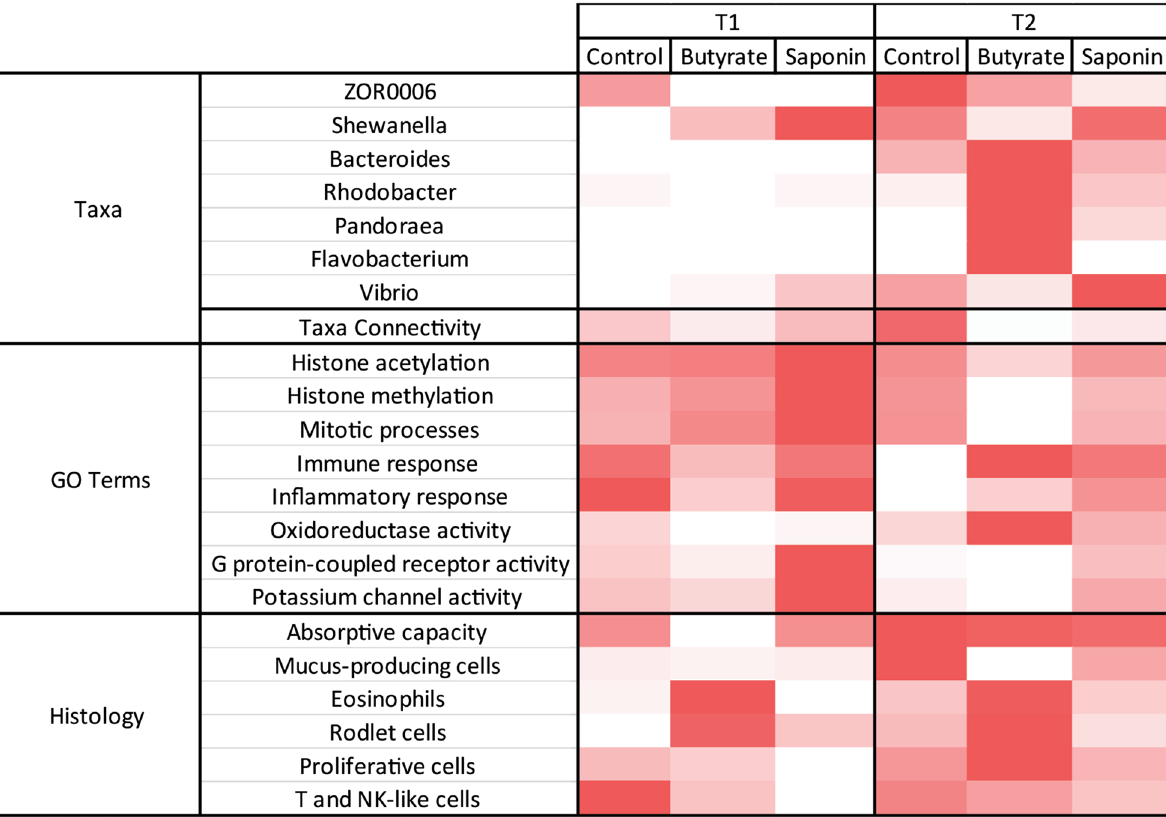
Fig. 8 The heatmap brings together the main observations of each analysis and compare them per diet and timepoint. The more representative genera are illustrated with the average relative abundance per timepoint and diet. The taxa connectivity contained the amount of pairs of taxa that correlate to each other in a significant fashion ( p 0.05). The GO terms contain the transcripts per million (tpm) of all genes expressed in the ≤ dataset that collapsed under that GO term. All histological parameters are normalized and scaled (from 0 to 1). Each individual feature within the heatmap is normalized and colored from red (more present) to white